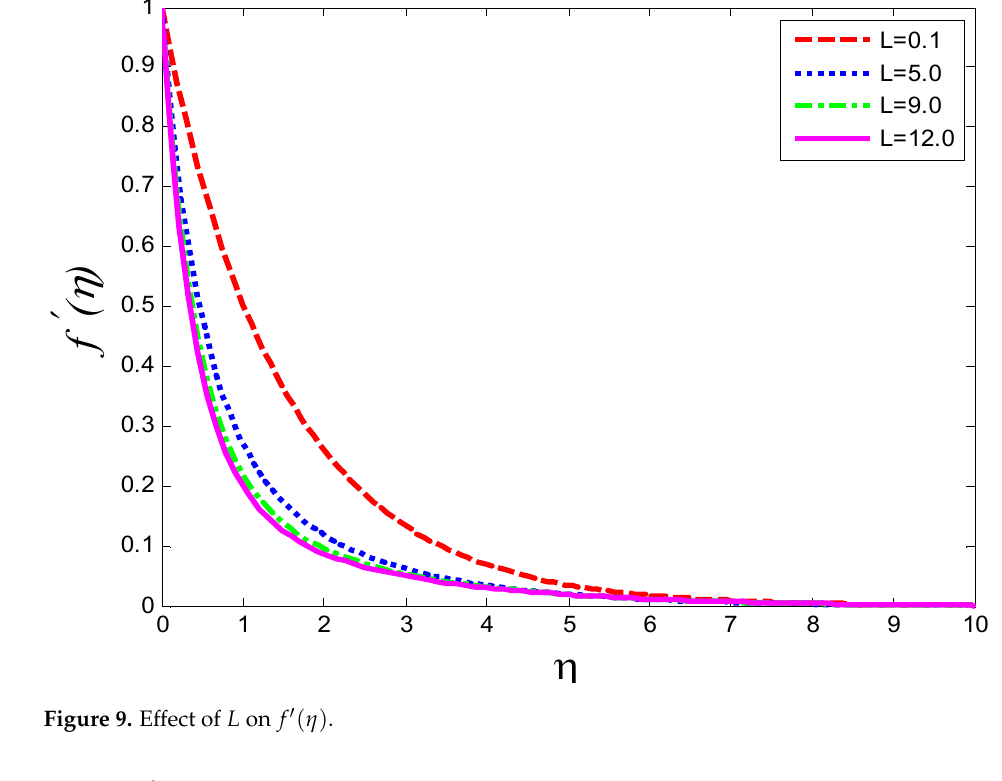
Figure 9. Effect of L on f (cid:48) ( η ) .